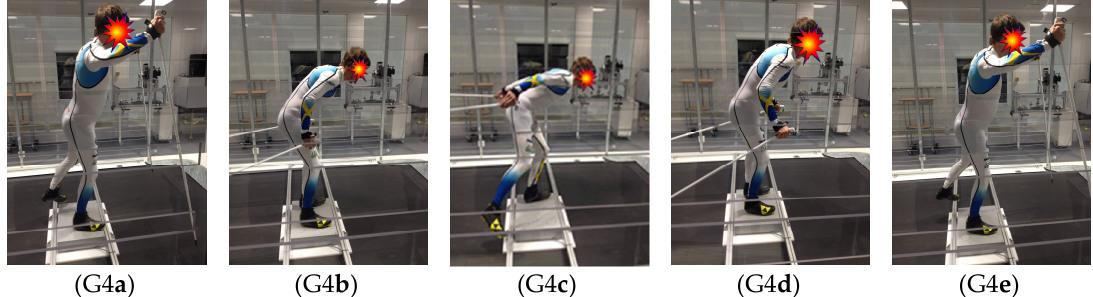
Figure 2. Pictures (G4 a –G4 d ) present sagittal plane images of the skier performing the selected four static positions representing the free style gear 4 technique. Picture (G4 e ) is similar to picture (G4 a ) and completes the range of